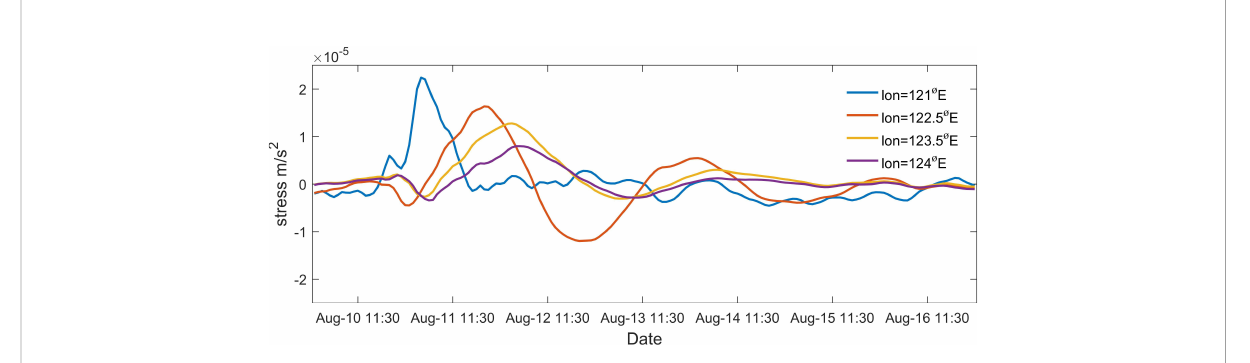
FIGURE 14 Time plot of pressure gradient force (m/s 2 ) at different longitude of 34°N. The blue, orange, yellow, and purple lines represent variation of pressure gradient forces with time at 121°E, 122.5°E, 123.5°E, and 124°E of 34°N,